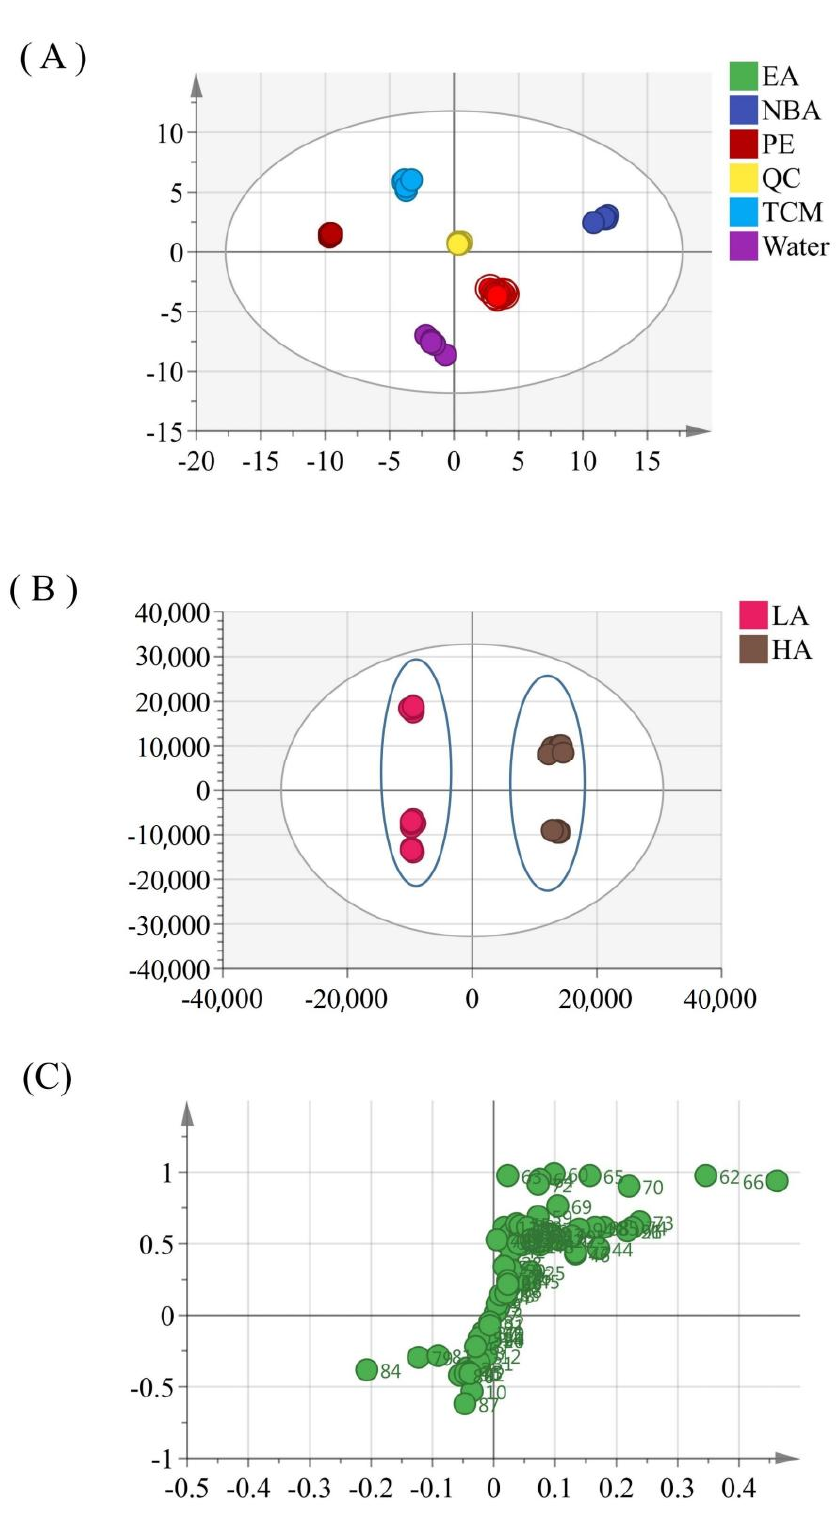
Figure 6. Score plots from principal component analysis ( A ), orthogonal partial least squares discriminant analysis ( B ), and loading plot models ( C ) in different layers from PPL.